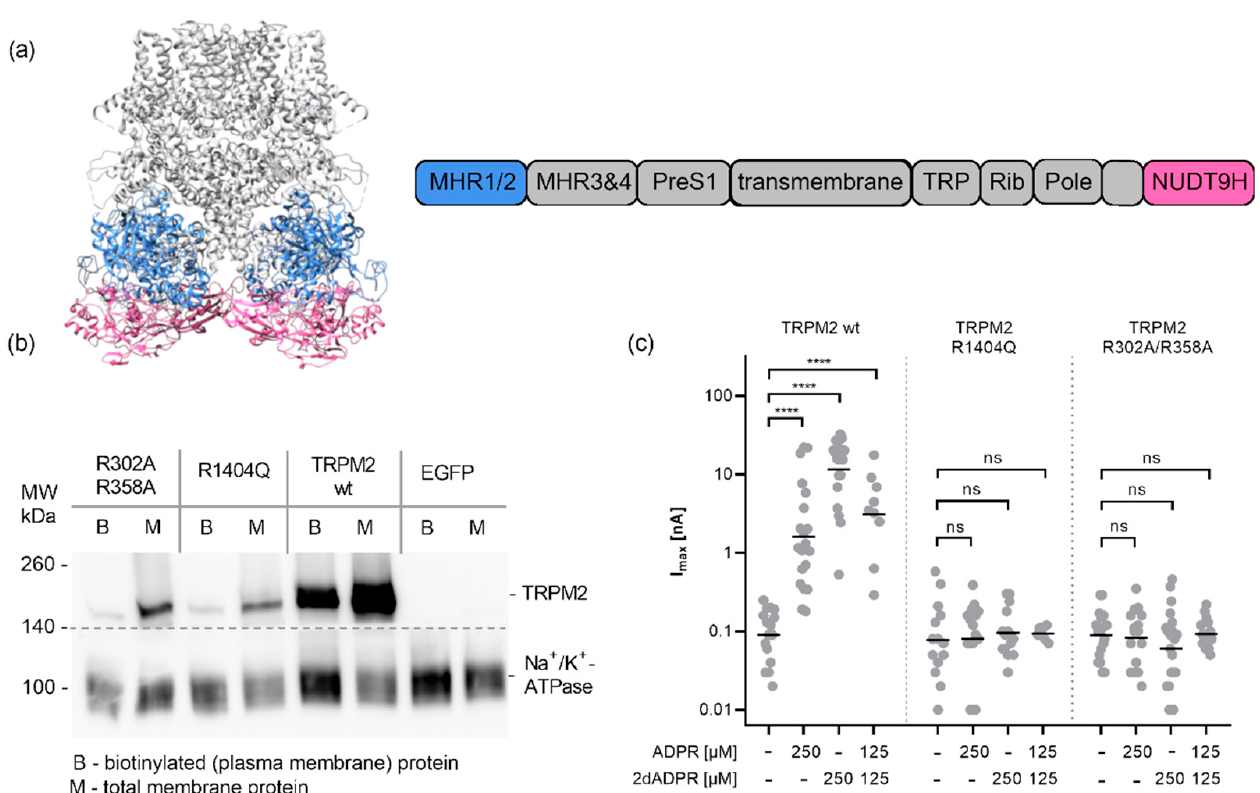
Figure 3. Effect of mutations in the MHR1/2 domain and in the NUDT9H domain on activation of TRPM2 by ADPR and 2 ′ -deoxy-ADPR. ( a ) Structure of TRPM2, visualization of PDB:6PUS [18] gen- erated in UCSF chimera [34], MHR1/2 (blue) and NUDT9H (magenta) domains are highlighted. ( b )